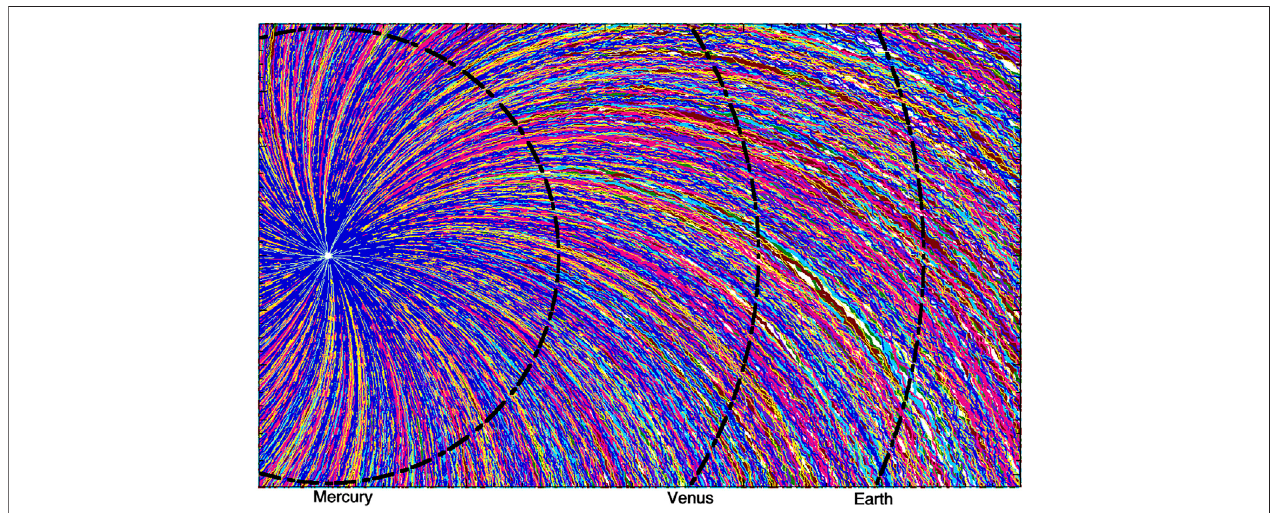
FIGURE 1 | A simple sketch (to scale) of the background heliospheric structure that forms a magnetic ductwork for the transport of energetic particles and that produces the intermittent driving of the Earth ’ s magnetosphere. In the sketch no fast-versus-slow wind is depicted and no ejecta is depicted.